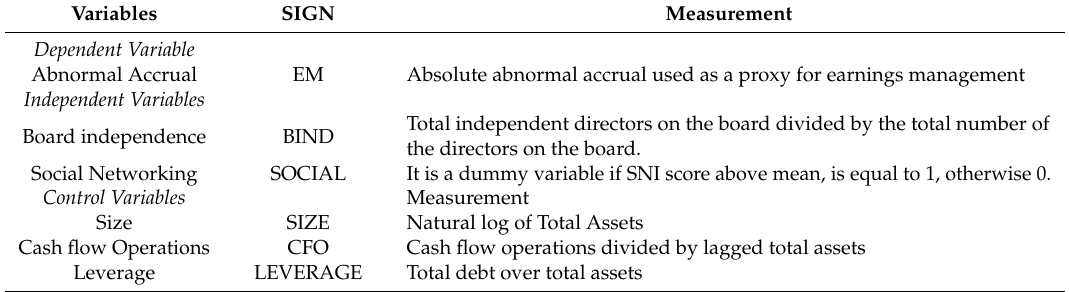
Table 1. Variables Definition.